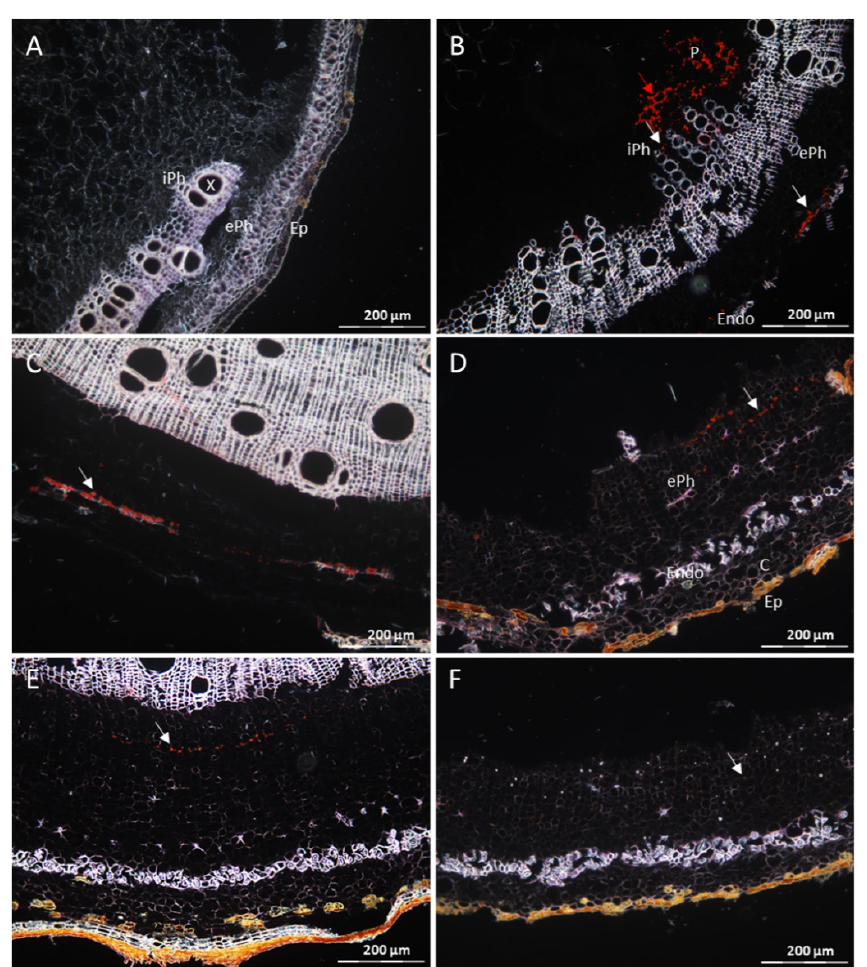
Figure 3. Distribution of CBSV-Mo83 RNA in cross-tissue sections of DSC 167 and TMS 96/0304 cassava stems. Cross sections of cassava stem tissues subjected to RNAscope ® ISH using a CBSV- Mo83 probe. ( A ) Absence of signals in stem sections of uninfected TMS 96/0304. ( B ) Red dots indicate presence of viral RNA in phloem cells (external and internal phloem, white arrows) and in parenchyma cells of TMS 96/0304 (red arrow). ( C – F ) In DSC 167, virus signals are found in external phloem only (( C – F ), white arrows). X, xylem; P, parenchyma; C, cortex; ePh, external phloem; iPh, inner phloem; Ep, epidermis; Endo, endodermis.